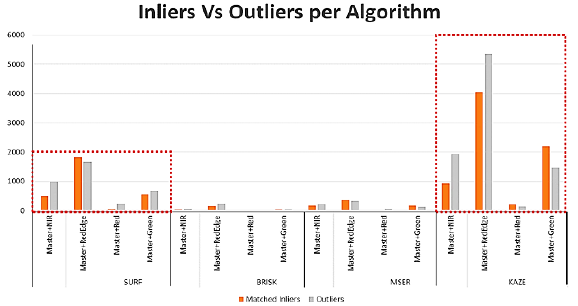
Figure 9. Illustrating inliers and outliers of matched Keypoints. Despite being seen to have more outliers than inliers in the first and second band combinations, the overall performance of KAZE depicts more inliers than the other algorithms. On the other hand, BRISK and MSER failed to converge to find sufficient points after 1000 iterations for the master and red band subsequent tests in this study.